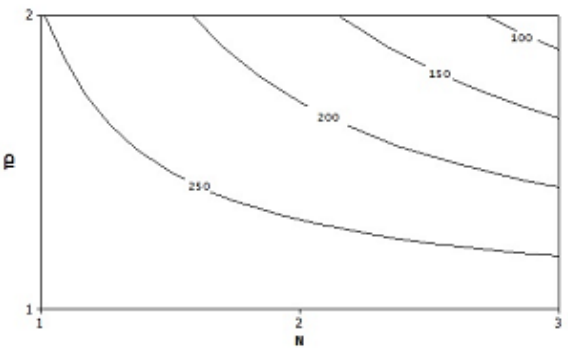
Fig. 8. Counter diagram of average water droplet size in terms of demulsifier types and mixing speed.